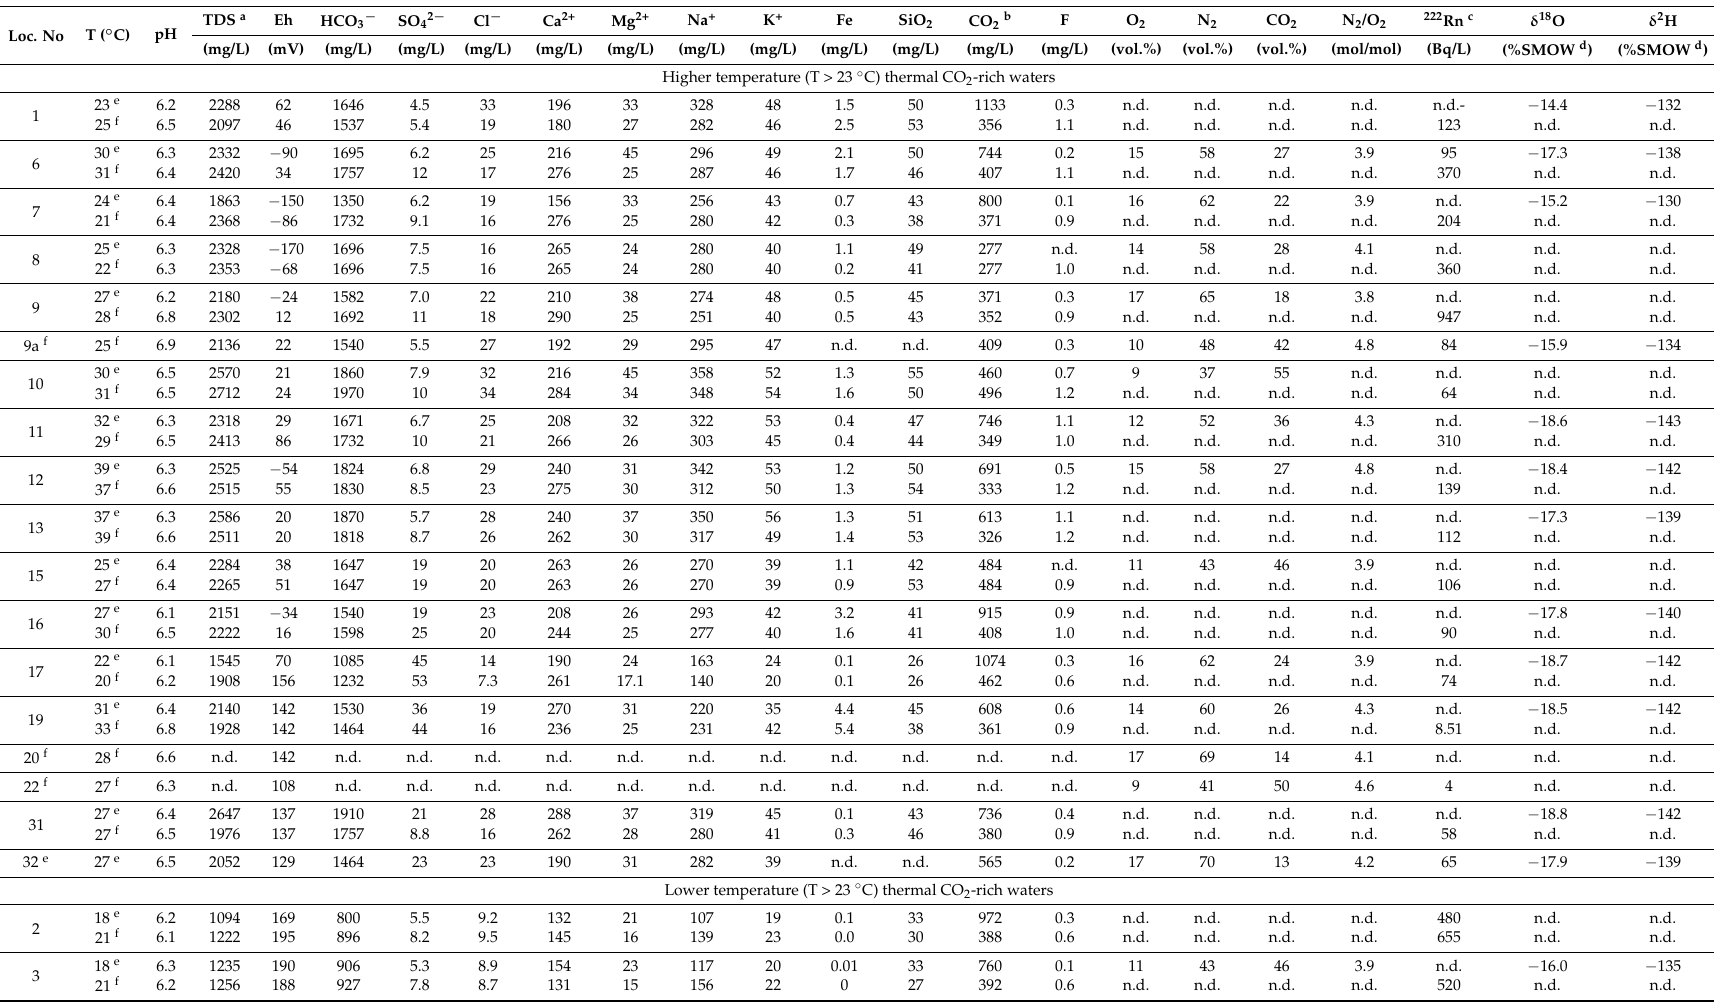
Table 1. Chemical, gas and isotopic compositions of Choygan spring waters. For each location number, the top line refers to sample collected in 2013 (this study) and the bottom line for samples collected in 2011 [26] (n.d. indicates no